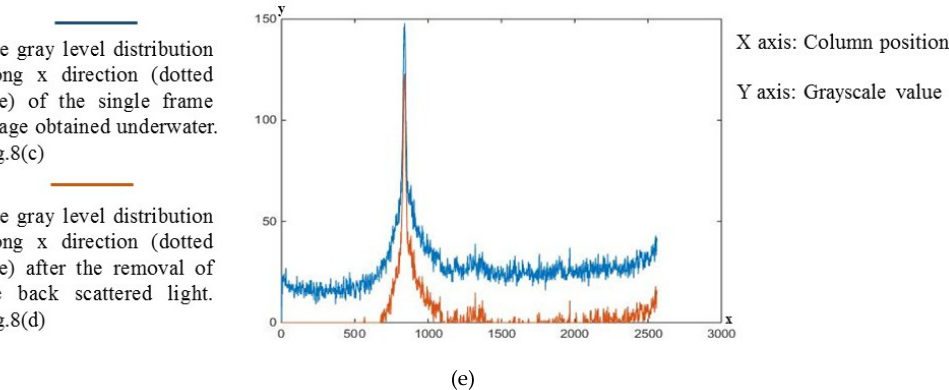
Figure 4. Determination of window mask. ( a ) Transverse intensity distribution of the projecting stripe light and the preset threshold of the window. ( b ) Single frame image obtained underwater. ( c ) Single frame image after applying smoothing filter to ( b ). Along the dotted line, the starting and ending points of the mask are determined accordingly with respect to this line. ( d ) Frame image after the removal of back scattered light. ( e ) Gray level distribution along the x direction (dotted line) before and after the removal of backscattering.